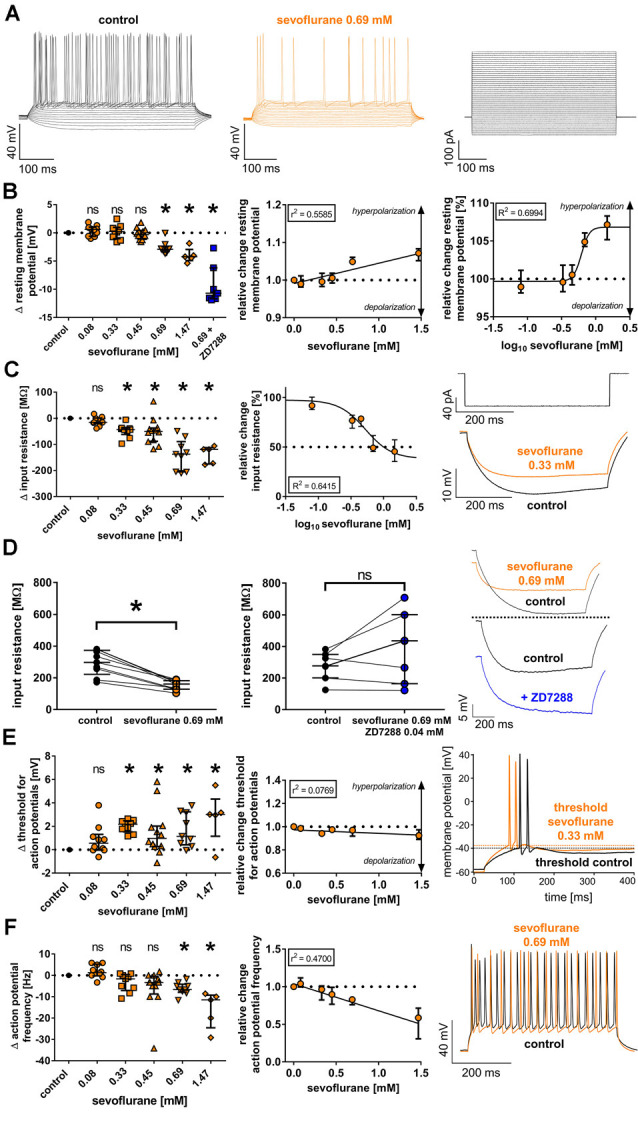
(A) Currents from −90 pA to +360 pA (10-pA steps) were injected into thalamocortical relay neurons and subsequent changes of the membrane potential were recorded under baseline conditions and in the presence of sevoflurane (representative current trace at 0.69 mM) in the current-clamp mode, with the corresponding current protocol depicted on the right. For clarity, only every second recording trace is depicted. (B) Sevoflurane significantly shifted the resting membrane potential [control: −56.9 (−58.7 to −55.6) mV, n = 45] towards hyperpolarization beginning at a concentration of 0.69 mM. This effect appeared to be concentration-dependent applying linear regression analysis and non-linear regression analysis (using a four-parameter logistic equation with sigmoidal curve fitting). Δ: absolute change compared to control. ns, not significant. *p < 0.05. log10: logarithmic scale of sevoflurane concentration (mM). (C) Sevoflurane significantly reduced neuronal input resistance [control: 227.6 (181.3–276.7) MΩ, n = 45] beginning at a concentration of 0.33 mM in a dose-dependent manner. The input resistance was measured by injecting a hyperpolarizing current (−90 pA). The current protocol with representative voltage traces under baseline conditions and in the presence of 0.33 mM sevoflurane is shown on the right. (D) While 0.69 mM sevoflurane led to a significant reduction of the neuronal input resistance, coapplying 0.04 mM of the selective HCN channel blocker ZD7288 reversed this effect. Representative voltage traces from both the sole application of 0.69 mM sevoflurane as well as in the presence of sevoflurane and 0.04 mM ZD7288 with respective baseline recordings are depicted on the right. (E) From a concentration of 0.33 mM on, sevoflurane significantly shifted the threshold for action potential firing [control: −38.9 (−40.1 to −36.0) mV, n = 45] towards depolarization. However, the linear regression analysis showed that this effect did not significantly correlate with the applied concentration. Representative voltage traces under control conditions and after application of 0.33 mM sevoflurane can be seen on the right, with the threshold for action potential firing being indicated by dotted lines. (F) In the presence of 0.69 mM and 1.47 mM, sevoflurane significantly decreased the frequency of tonic action potential firing [control: 39.2 (33.8–43.8) Hz, n = 45], which was induced by depolarizing current injections. Using linear regression analysis, the reduction appeared to be concentration-dependent. On the right, we show representative voltage traces of tonic action potential firing under control conditions and in the presence of 0.69 mM.